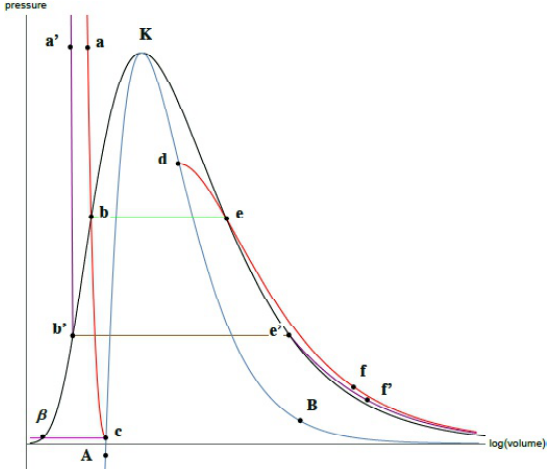
Fig. 4. The isobar be represents the equilibrium states at temperature T while b ’ e ’, the corresponding states at temperature T .  bKe and cKdB are the outer and inner 